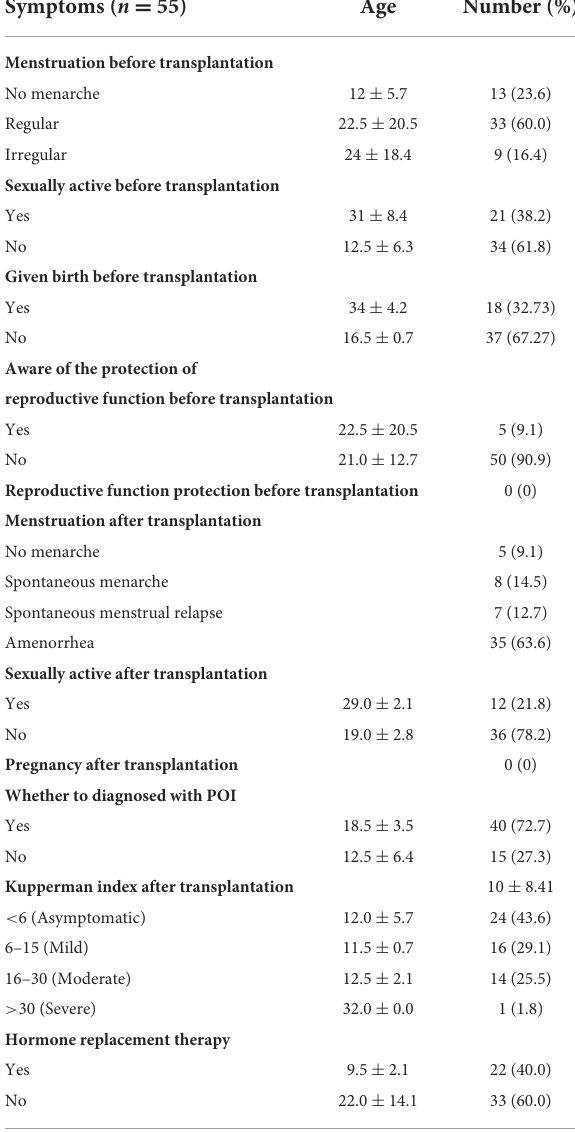
TABLE 2 The menstruation and menopausal symptoms of patients before and after